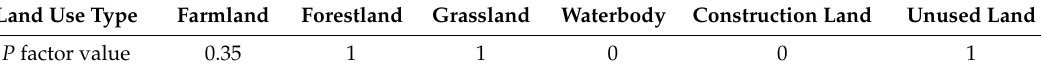
Figure 3. Land use classification map of the CLB in 2017. Table 2. The P factor value of different land use types.